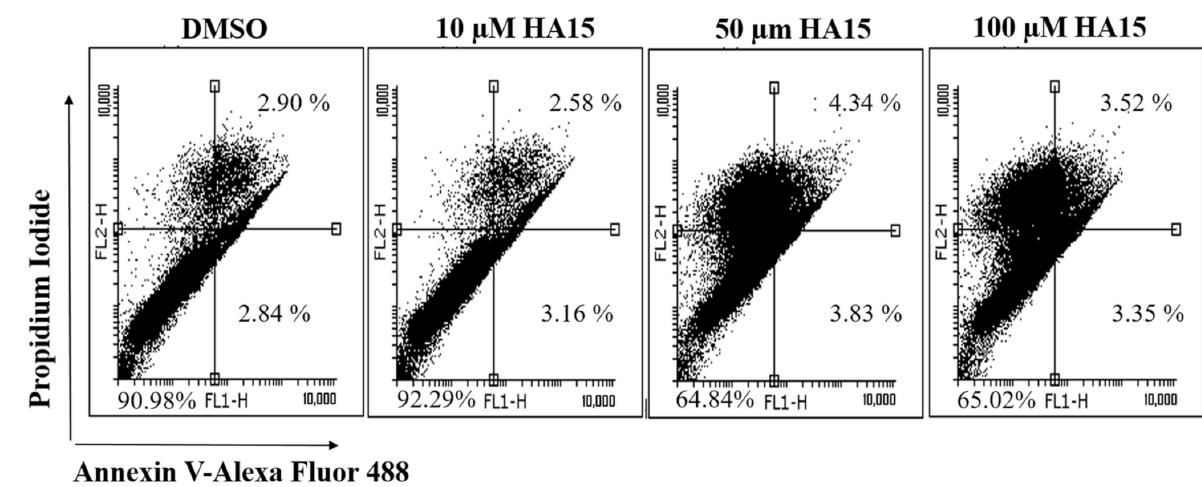
Figure 6. Scatter plots of WM983A melanoma cells after HA15 treatment using the Annexin V FITC/propidium iodide assay. First, cells were starved for 14 h, and the medium was replaced with complete medium containing 10, 50, and 100 µ M HA15. The cells were then incubated for 48 h followed by staining with Annexin V-FITC/propidium iodide. The Annexin V-FITC-positive/PI-negative cells located in the lower right quadrant of the histogram represent early apoptotic cells; the Annexin V-FITC-positive/PI-positive cells in the upper right quadrant represent late apoptotic